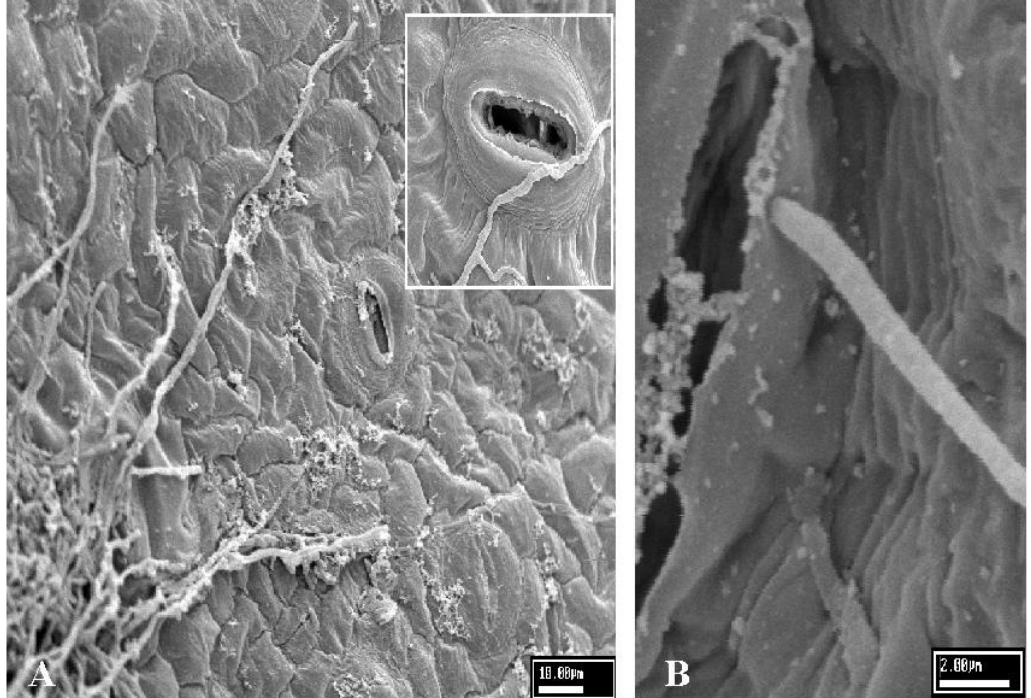
Fig. 2. SEM photomicrographs of the leaf surface 48 h after inoculation with Phaeoacremonium inflatipes showing (A) the fungus bypassing the stomatal pore and (B) apparent penetration of a guard cell of the stomata